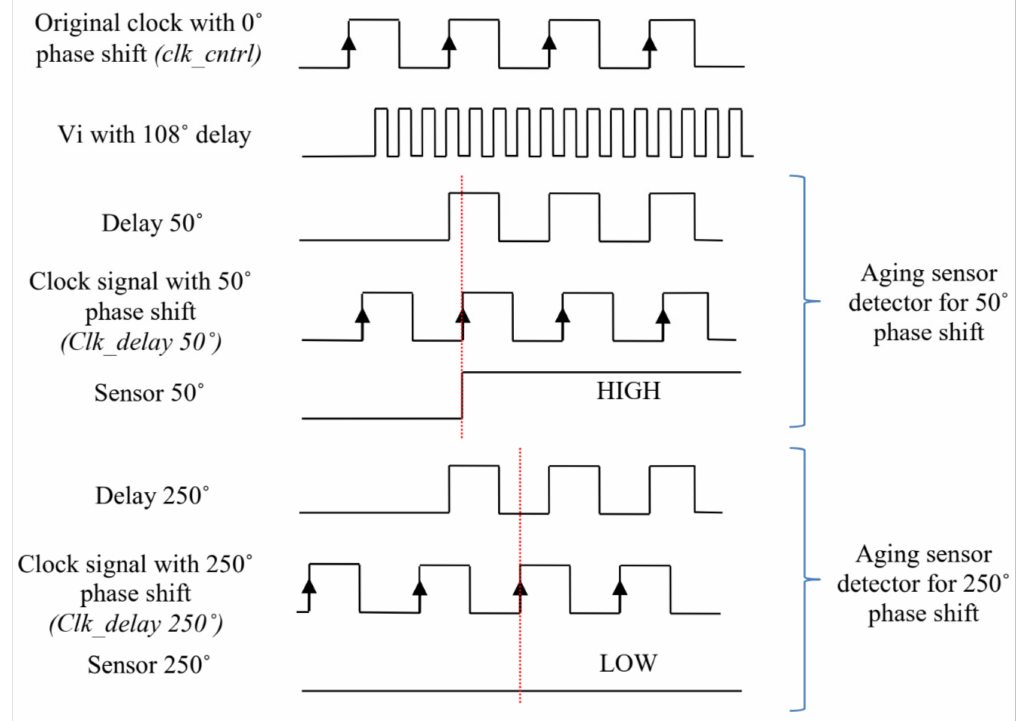
Figure 6. Timing diagram to detect the phase delay for an aging